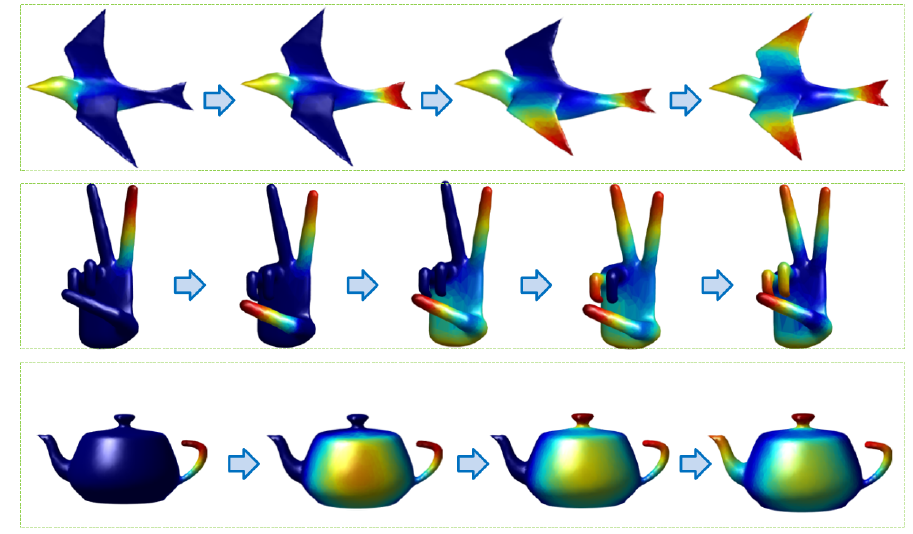
Figure 8. Application of our framework to saliency detection on the bird, hand, and teapot models. The subfigures from left to right demonstrate the gradually increasing salient